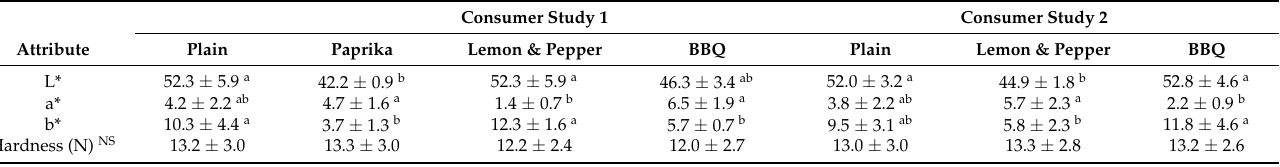
Table 1. Instrumental color 1 and hardness 2 values of catfish skin